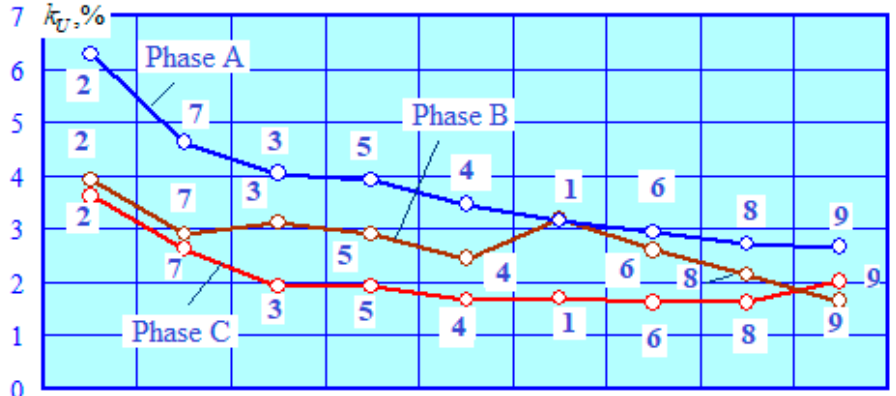
Figure 20. Maximum total harmonic distortion values at 220 kV buses of TS No. 4—callout numbers correspond to those in Figure 15.